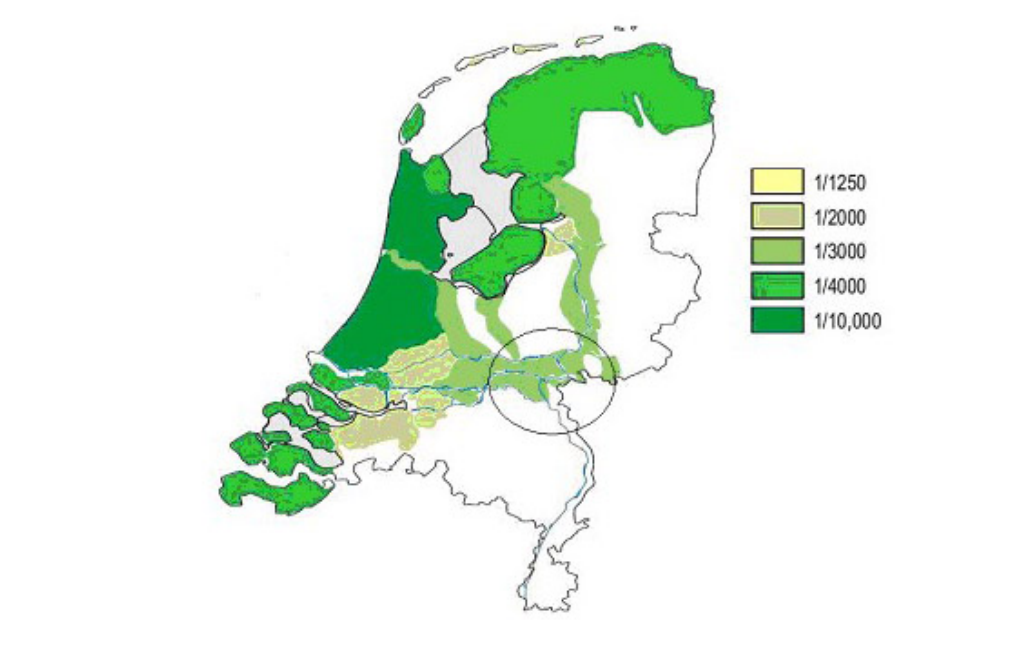
Fig. 2. Map of the Netherlands showing the differentiation in safety norms. The location of the study area is indicated with the circle (DWW,